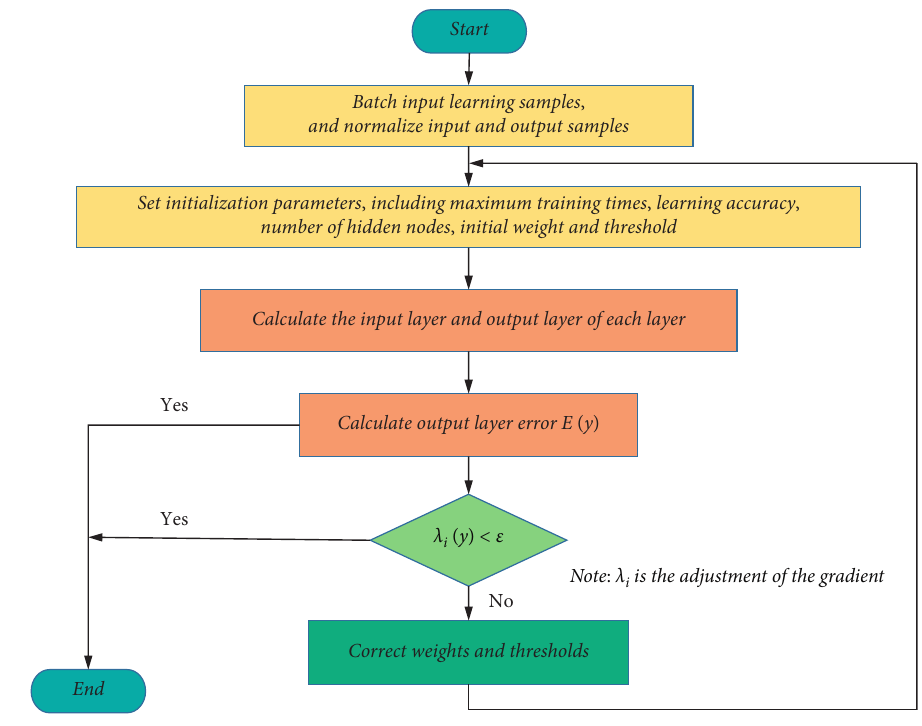
Figure 4: A flowchart of Levenberg-Marquardt Table 5: Normalized data of the specimens.